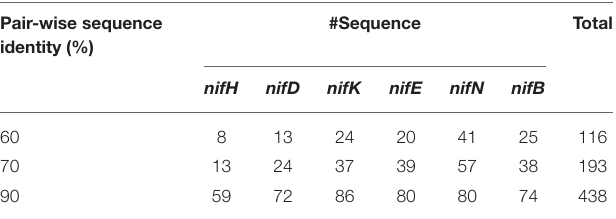
TABLE 1 | Summary of the collected dataset with different percentage of sequence